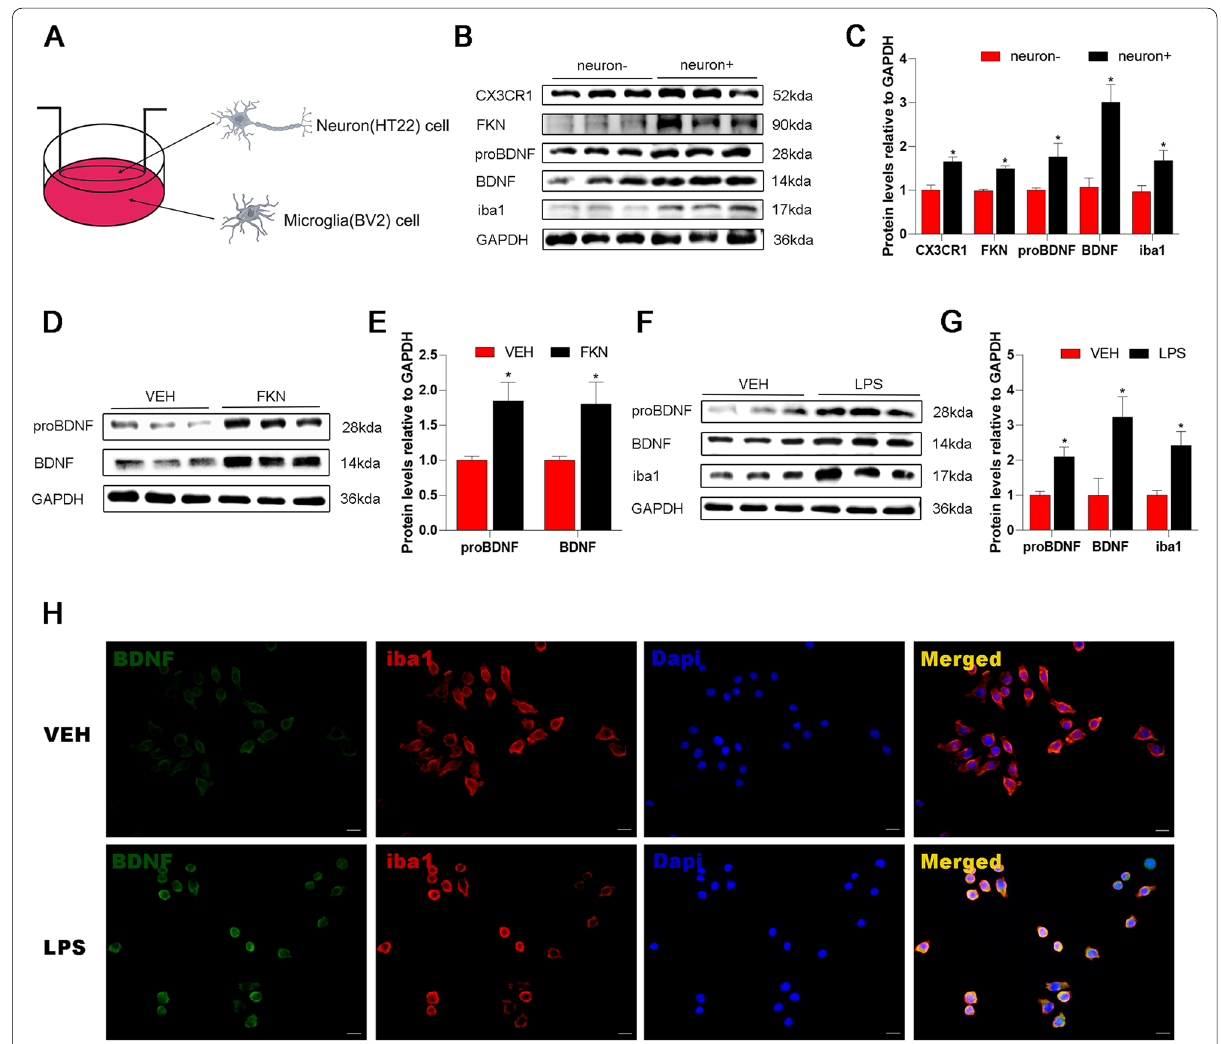
Fig. 4 Neurons interact with microglia via the FKN/CX3CR1 axis in HT22-BV2 cocultures and enhance the release of BDNF by BV2 microglia. A Diagram of the HT22-BV2 coculture experiment. B Representative western blot images showing CX3CR1/FKN/proBDNF/BDNF/iba1 protein produced by BV2 cells in the presence of HT22 cells. C Quantification of CX3CR1/FKN/proBDNF/BDNF/iba1 protein levels in neuron- and neuron cultures. Mean SEM; unpaired t test versus neuron- group; n 3 rats per group; * P < 0.05. D Western blot images showing proBDNF/ + ± = BDNF/iba1 protein produced by BV2 cells in response to FKN stimulation. E Quantification of proBDNF and BDNF protein levels in the VEH group and FKN group. Mean SEM; unpaired t test versus VEH group; n 3 rats per group; * P < 0.05. F Representative western blot films showing proBDNF, ± = BDNF, and iba1 protein produced by BV2 cells in the VEH group and the LPS group. G Western blot analysis showed that the proBDNF, BDNF, and iba1 protein levels in the LPS group were upregulated compared to those in the VEH group. Mean SEM; unpaired t test versus VEH group; n 3 ± = per group; * P < 0.05. H Representative immunofluorescence staining of BDNF (green) and iba1 (red) in the VEH and LPS groups. Scale bar 20 μm. = VEH,